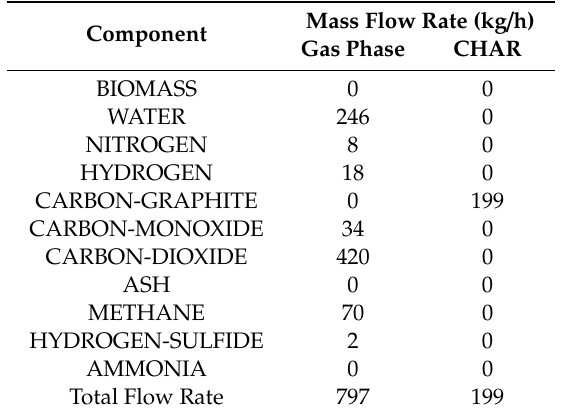
Table 2. Pyrolysis volatiles and char stream